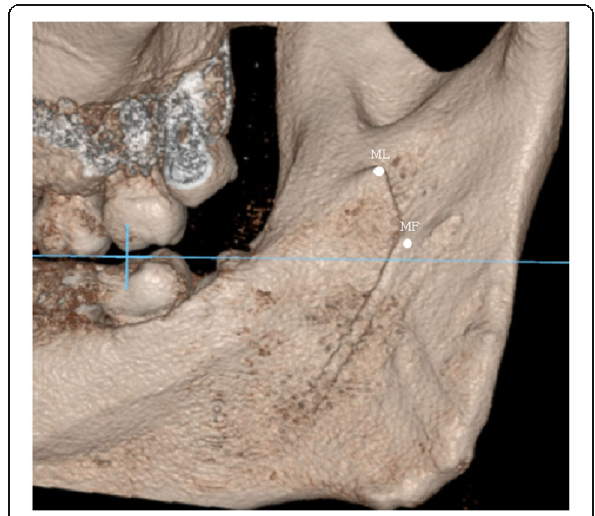
Fig. 3 Both of the ML and MF above the occlusal plane; ML in front of MF. The blue line indicates the occlusal plane